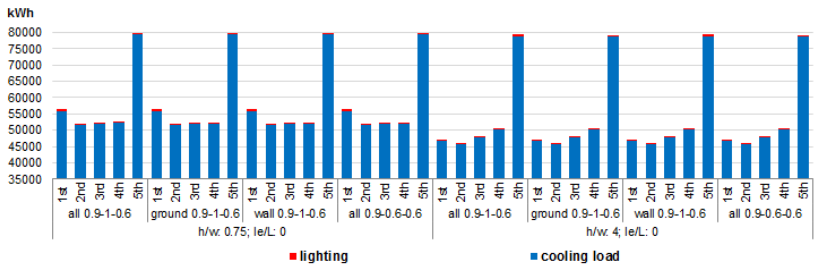
Fig. 12. One-year energy performance of fenestration models on 9 m wide classrooms in 2 variations of the urban geometry with 3 variations of the external reflectances in Yogyakarta.